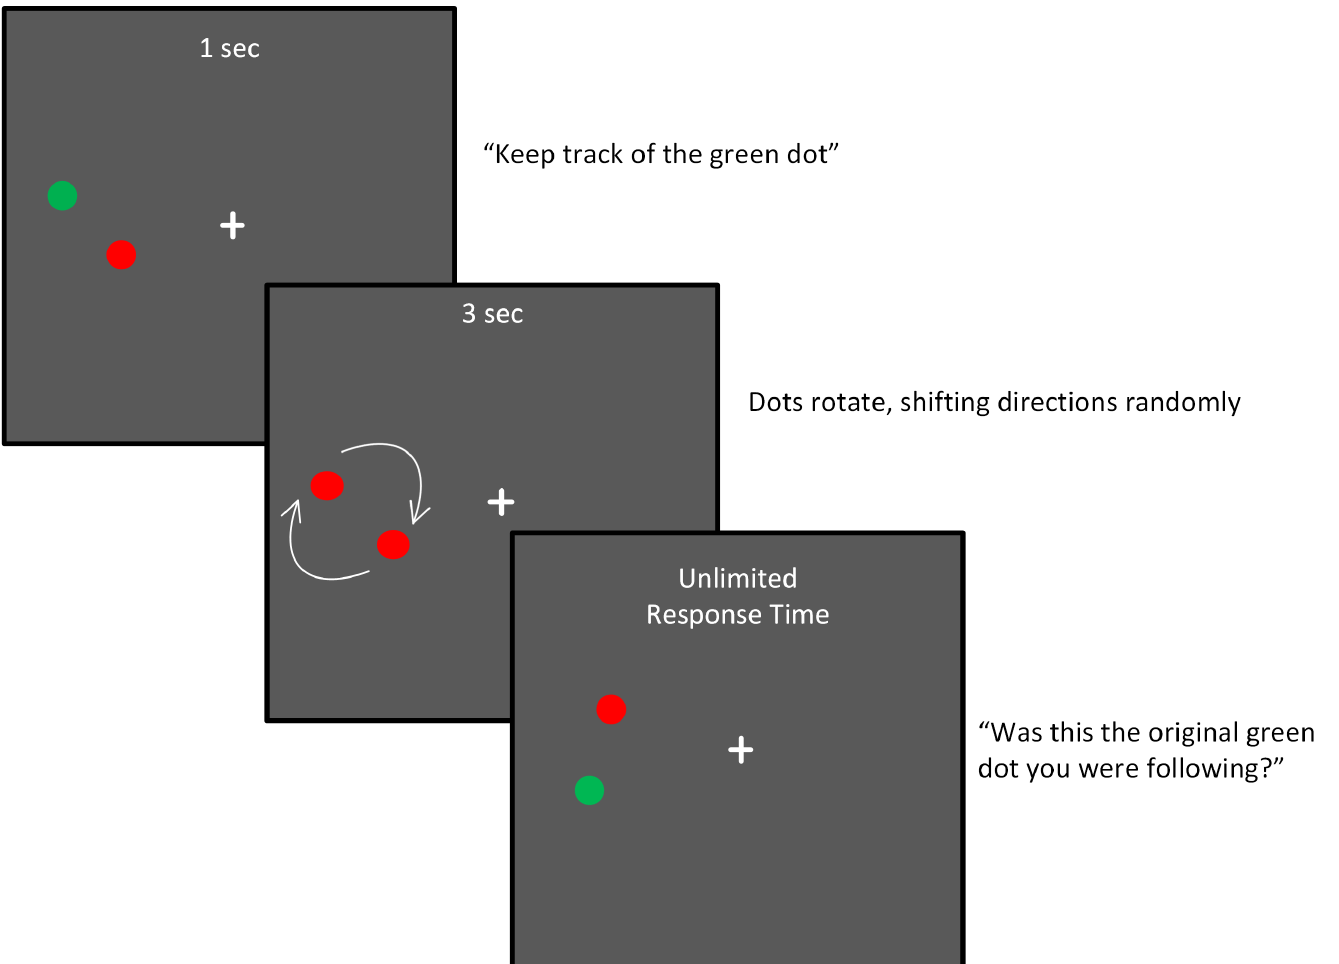
Fig 1. Methods for Experiment 1. Dots rotated at one of four speeds as described in the text, and were placed on either the left or the right of the fixation cross on each trial.